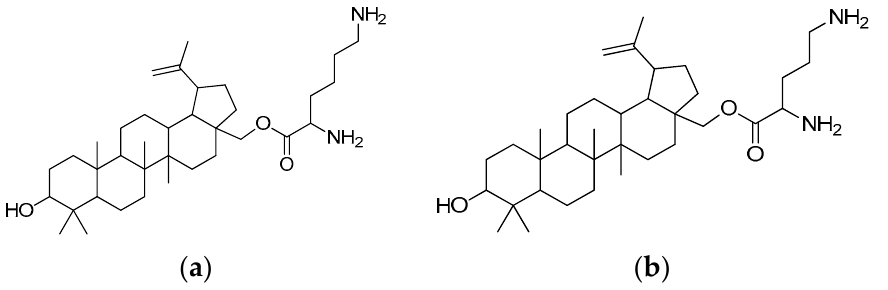
Figure 18. ( a ) Betulin-L-lysine; ( b )